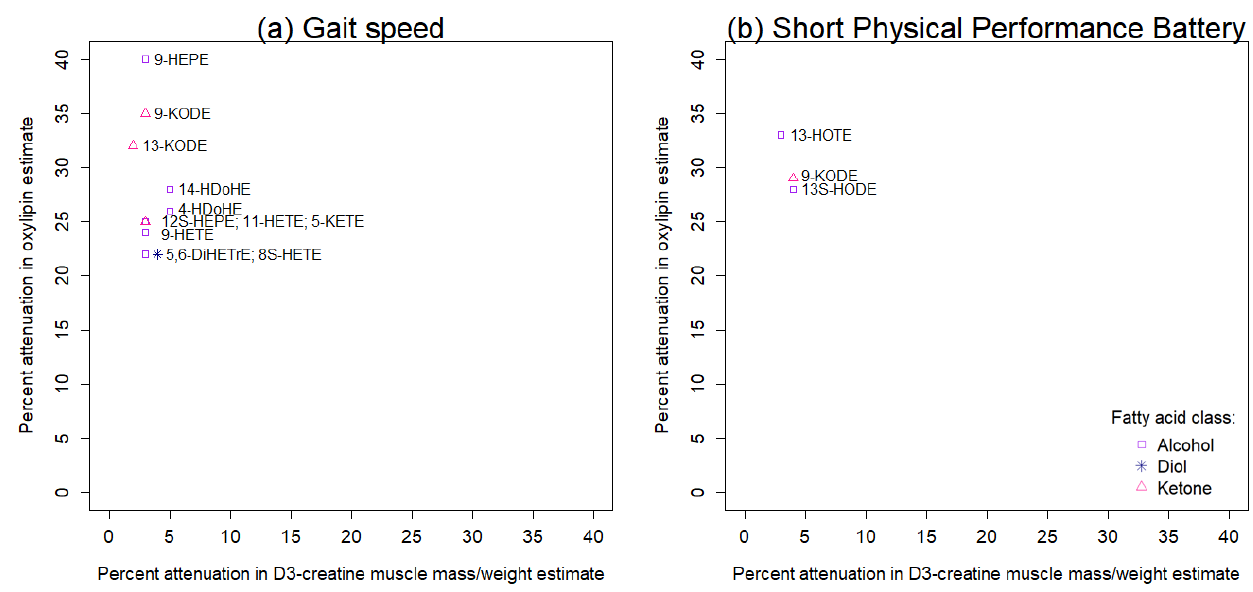
Figure 4. Attenuation in multivariable adjusted associations between select oxylipins and ( a ) gait speed or ( b ) the Short Physical Performance Battery after additionally adjusting for D3-creatine muscle mass/weight versus attenuation in multivariable adjusted associations between D3-creatine muscle mass/weight and ( a ) gait speed or ( b ) the Short Physical Performance Battery after additionally adjusting for an oxylipin among 463 MrOS men. Models were initially adjusted for age, more than high school education, Physical Activity Scale for the Elderly, Western style dietary pattern score, and fish oil supplementation. Oxylipin abbreviations are listed in Table